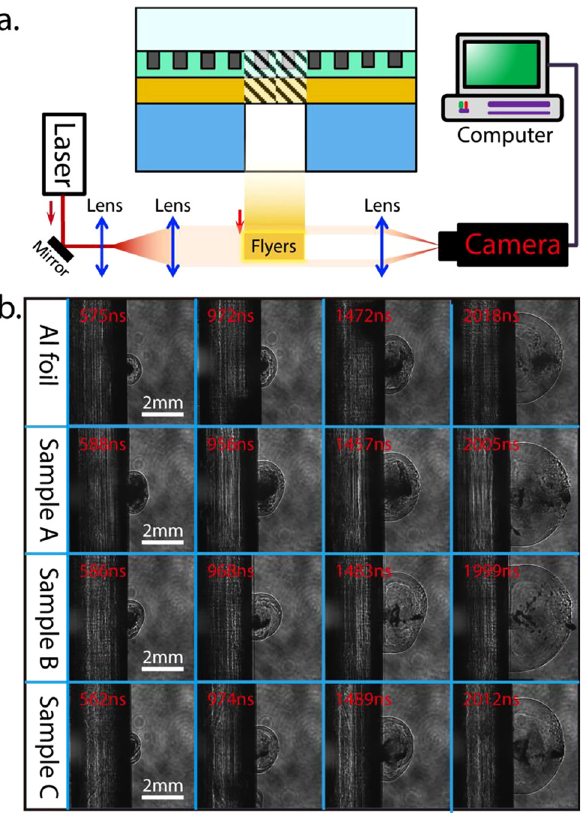
Figure 6: (a) The time-resolved shadow photograph measurement schematic diagram. A detection laser beam parallel to the bottom side of the accelerated chamber is used to illuminate the flyer out of the accelerated chamber, and the shadow is recorded by a high- speed CCD camera; (b) the measured time-resolved shadowgraphs of the fl yer from the Al foil sample, Sample A, B, and C at different time steps. The times and the scale bar are denoted by the red and white characters, respectively. Time-resolved shadowgraphs of laser-ablated fl yer plates at different time